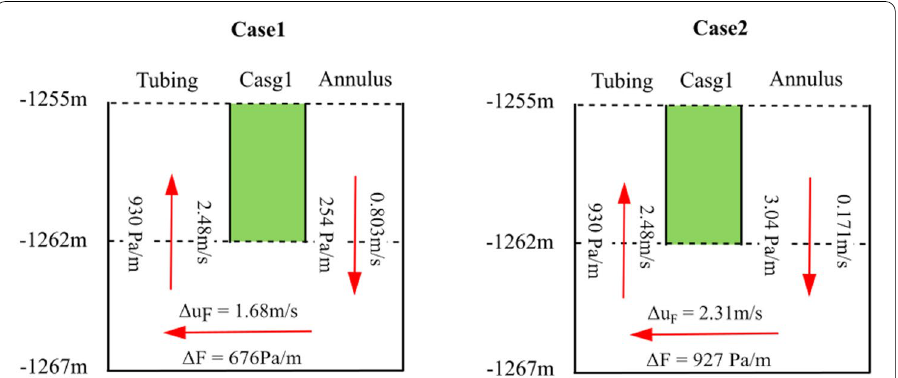
Fig. 10 Illustration for cases 1 and 2 at the bottom of the well. Working fluid velocity u F and frictional pressure F values are shown for Cases 1 and 2. These values were extracted from the output files for connections between the bottom cell and the one above, as depicted by the red vertical arrows. The horizontal arrow is not modelled in T2Well/EOS1, but is here to represent the differences between the two cells. This image is not to